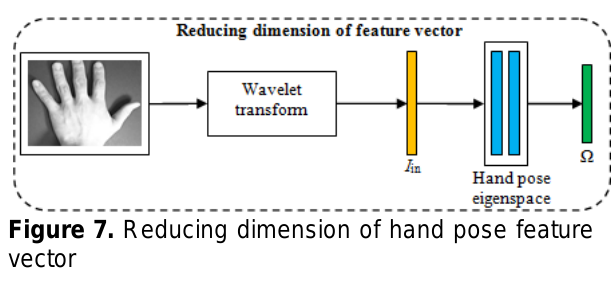
Figure 7. Reducing dimension of hand pose feature vector